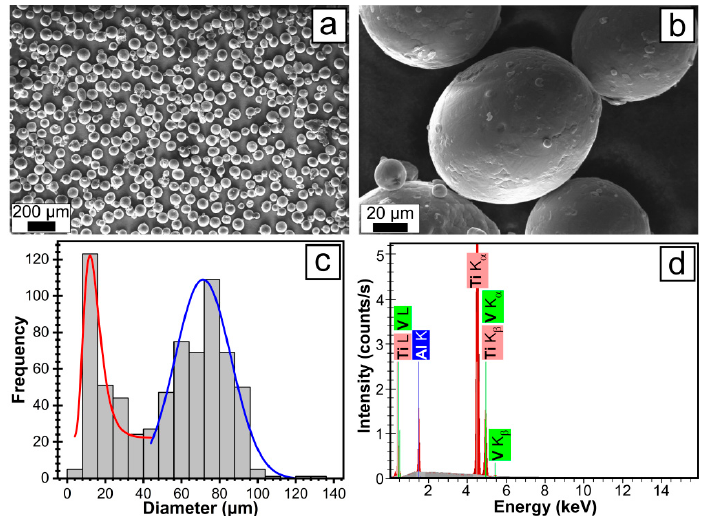
Figure 2. ( a ) Overview of the SEM micrograph for Ti6Al4V powder used as source material for LMD manufacturing of prototype bone plates; ( b ) Detailed SEM morphology of the small micron-sized particles adhering to the 50–130 µm diameter large particles; ( c ) Particle size distribution histograms; ( d ) EDXS spectrum characteristic of the Ti6Al4V powder.